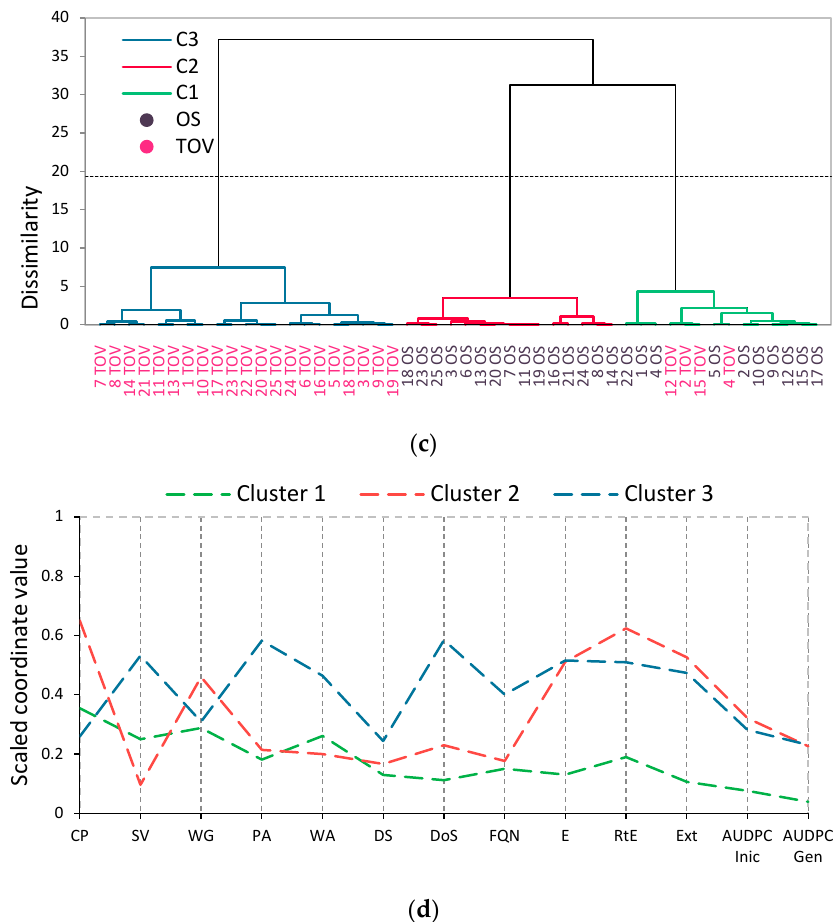
Figure 6. Principal component analysis of measured quality variables derived as the mean differ- ence between infected and control (uninfected) samples of 25 winter wheat cultivars cultivated at two locations (Osijek-OS and Tovarnik-TOV). ( a ) Correlations between measured variables and the two principal components; ( b ) Projections of cultivars on the PCA coordinate plot; “green points” represent Cluster 1 (C1), “red points” represent Cluster 2 (C2), “blue points” represent Cluster 3 (C3) displayed and sorted by ( c ) Agglomerative hierarchical cluster analysis; ( d ) Parallel coordinate plot of differences representing mean rescaled value (0,1) of distances for validating each cluster.